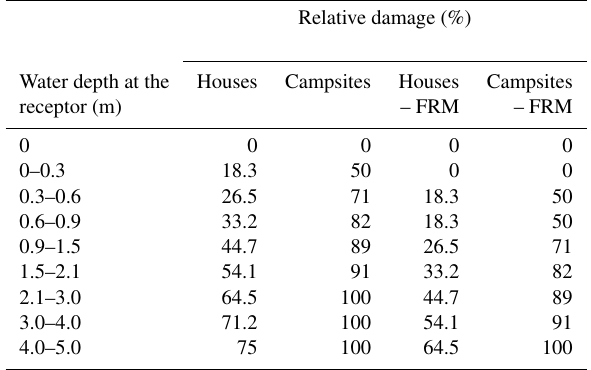
Table 5. Vulnerability relation for flooding adopted for the receptors at Lido degli Estensi–Spina without (a) and with flood resilience measures (b)